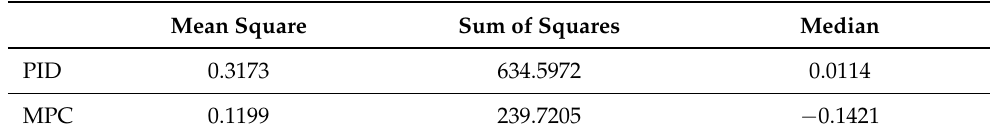
Table 2. Quantitative performance comparison of the PID- and MPC-based control loops based on set-point deviation.